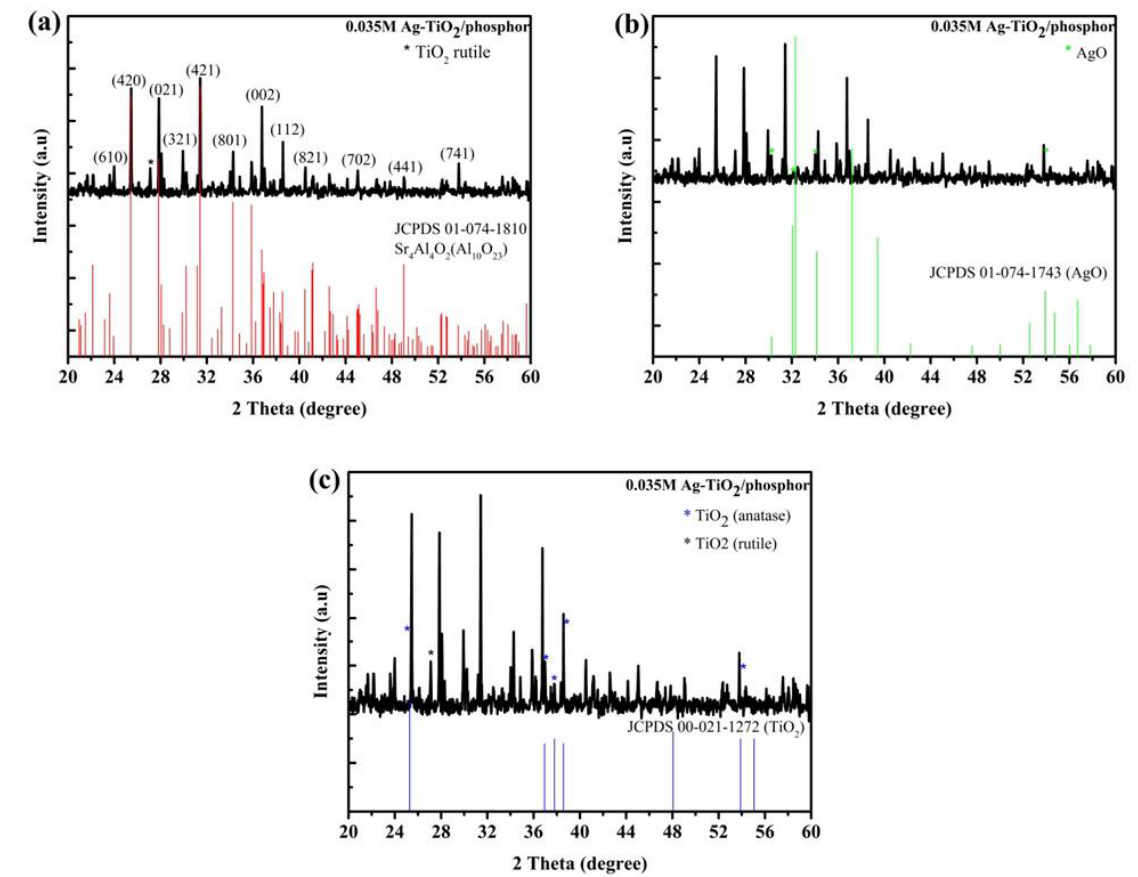
Figure 1. XRD spectra for 0.035 M Ag-TiO 2 /phosphor compared to JCPDS for ( a ) Sr 4 Al 4 O 2 (Al 10 O 23 ), ( b ) AgO, and ( c ) TiO 2 .